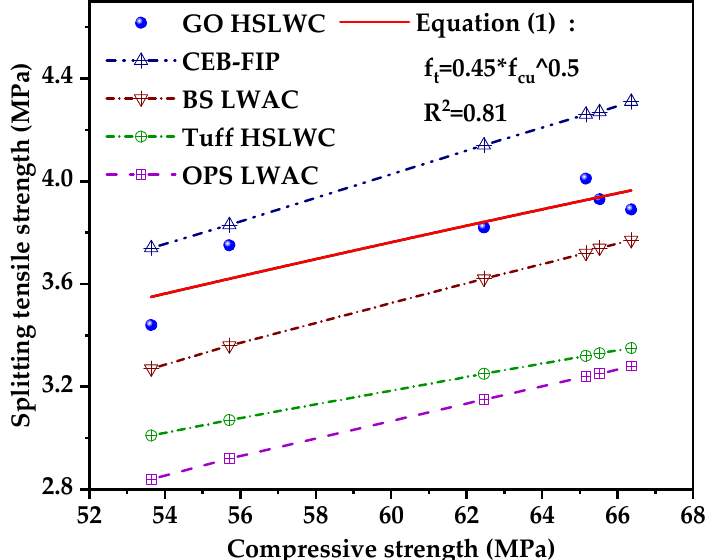
Figure 6. Relationship between the 28-day compressive strength and the 28-day splitting tensile strength of concrete.